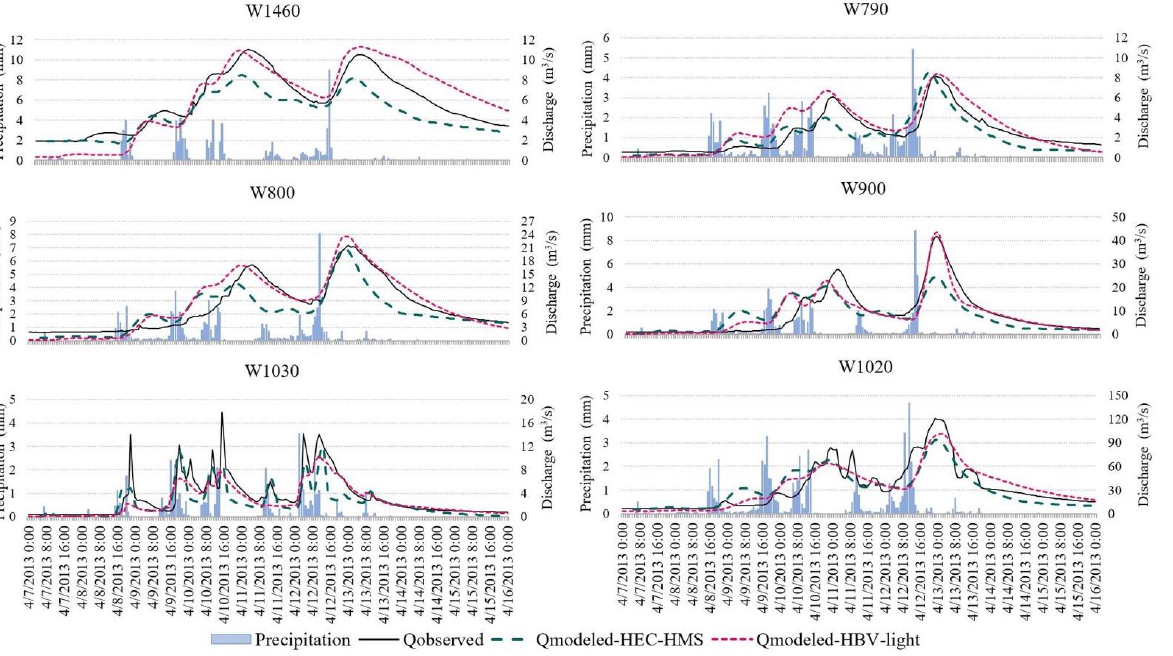
Figure 5. Precipitation, observed and modeled discharge of the 7 – 15 April 2013 rain event at the six gauged stations.